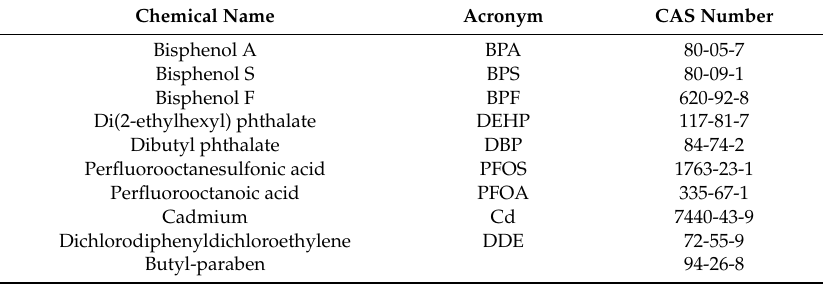
Table 1. The ten chemicals studied in